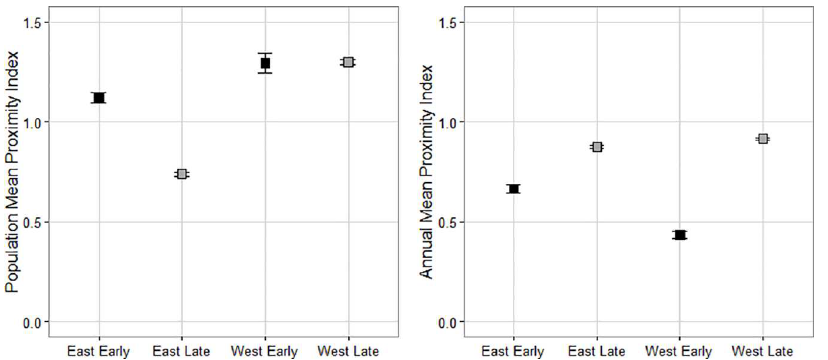
Fig 4. Mean caribou proximity index values between time periods and study areas. A comparisonof mean proximity index values for borealcaribou ( Rangifertarandus caribou )betweenthe eastern and western study areas in the early period(black; prior to wide spread caribou habitat management policy application, 1995–2001) and late period(grey; followinghabitat management policy application,2009–2013)at the population and individualannualhome range scales. Error bars represent standard